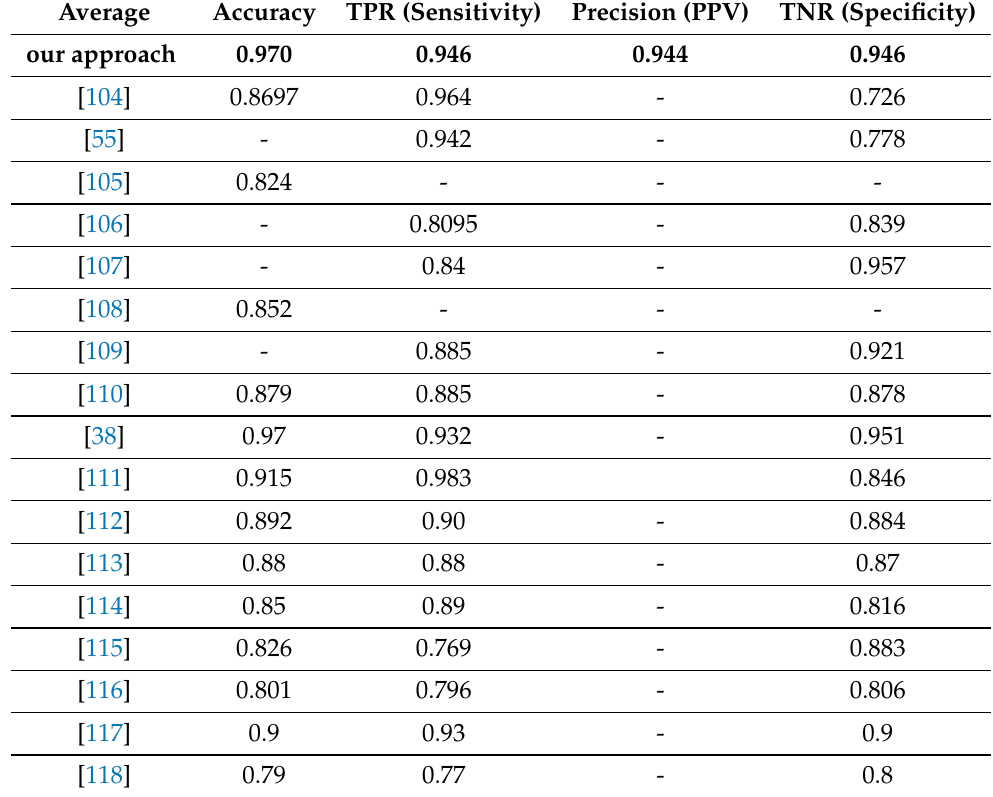
Table 11. Comparative analysis of our method with state-of-the-art methods using PhysioNet